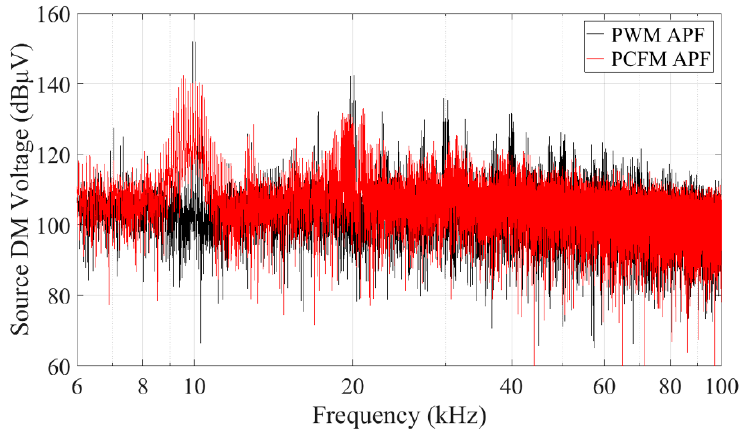
Figure 16. Experimental results of the source DM voltage v DMS spectra of APF under the nonlinear load II (Sawtooth PCFM APF with ∆ f c = 800 Hz).